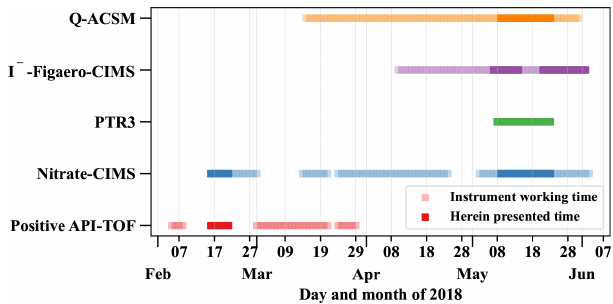
Figure 2. Overview of the operation times of the individual mass spectrometers and the herein presented time periods. The herein presented times are chosen by filtering for typical dry season con- ditions (westerly winds, clear sky) and removing all periods with uncertain data quality, e.g., due to technical difficulties and power